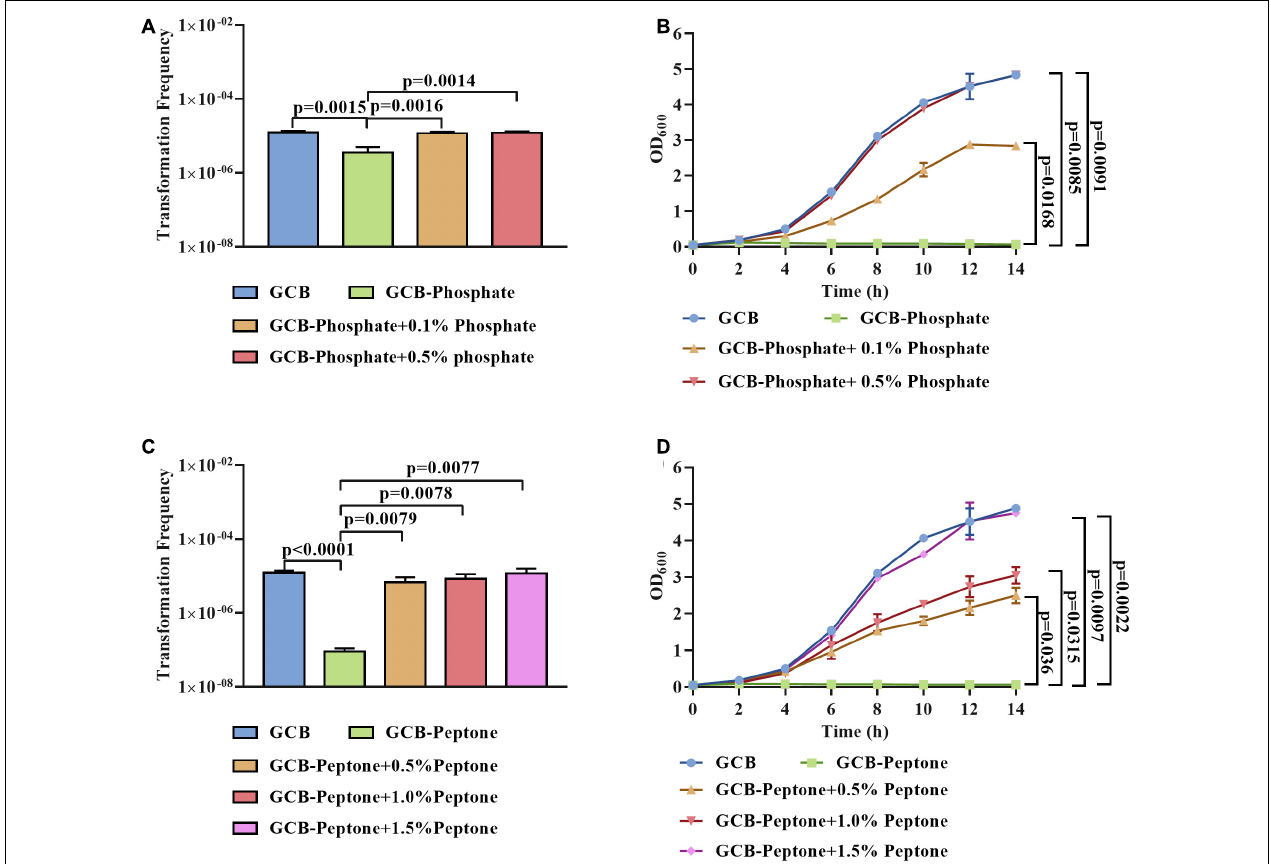
FIGURE 2 | The effect of phosphate and peptone on the natural transformation of R. anatipestifer ATCC 11845, respectively. (A) The natural transformation frequency of R. anatipestifer ATCC 11845 in the GCB medium, GCB medium without phosphate, and GCB medium without phosphate supplemented with 0.1 and 0.5% phosphate, respectively. The bacteria were grown to the exponential phase in the GCB medium, then, they were resuspended to an OD 600 of 1 in fresh GCB medium, GCB medium without phosphate, and GCB medium without phosphate supplemented with 0.1 and 0.5% phosphate, respectively. Following preincubation at 37 ◦ C for 1 h with shaking, the bacterial suspensions (0.3 ml) were used to perform the natural transformation assay as described in section “Materials and Methods.” (B) The growth curve of R. anatipestifer ATCC 11845 in GCB, GCB without phosphate, and GCB medium without phosphate supplemented with 0.1 and 0.5% phosphate, respectively. The bacteria were grown to the exponential phase in the GCB medium, then, they were resuspended in GCB, GCB without phosphate, and GCB medium without phosphate supplemented with 0.1 and 0.5% phosphate, respectively, to an OD 600 of 0.05. The bacteria were cultured at 37 ◦ C with shaking, and the OD 600 was measured every 2 h for 14 h. (C) The natural transformation frequency of R. anatipestifer ATCC 11845 in GCB, GCB without peptone, and GCB without peptone supplemented with 0.5,1 and 1.5% peptone, respectively. The bacteria were grown to the exponential phase in the GCB medium, then, they were resuspended to an OD 600 of 1 in fresh GCB medium, GCB medium without peptone, and GCB without peptone supplemented with 0.5,1 and 1.5% peptone, respectively. Following preincubation at 37 ◦ C for 1 h with shaking, the bacterial suspensions (0.3 ml) were used to perform the natural transformation assay as described in section “Materials and Methods.” (D) The growth curve of R. anatipestifer ATCC 11845 in GCB, GCB without peptone, and GCB without peptone supplemented with 0.5,1, and 1.5% peptone, respectively. The bacteria were grown to the exponential phase in the GCB medium, then, they were resuspended in GCB, GCB without peptone, and GCB without peptone supplemented with 0.5,1 and 1.5% peptone, respectively, to an OD 600 of 0.05. The bacteria were cultured at 37 ◦ C with shaking, and the OD 600 was measured every 2 h for 14